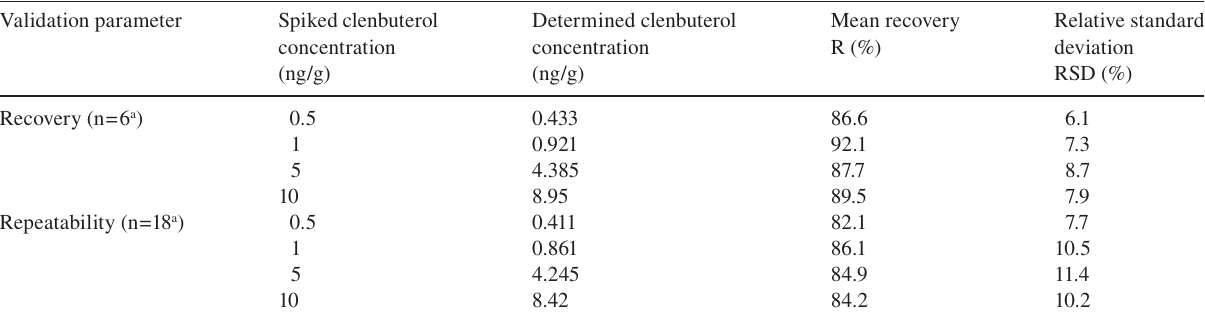
Table 1 Validation results of method recovery and repeatability for pig liver spiked with clenbuterol standard at concentration level of 0.5, 1, 5, and 10 ng/g.